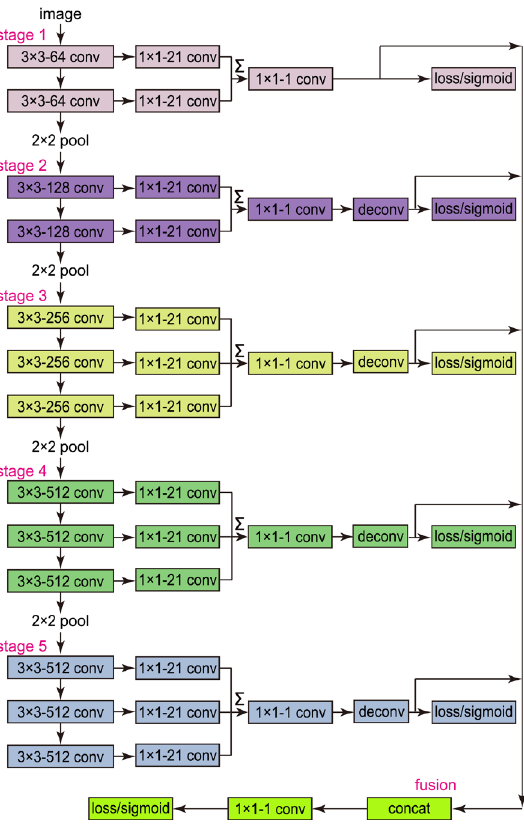
Figure 2. The RCF network architecture (Liu et al., 2018